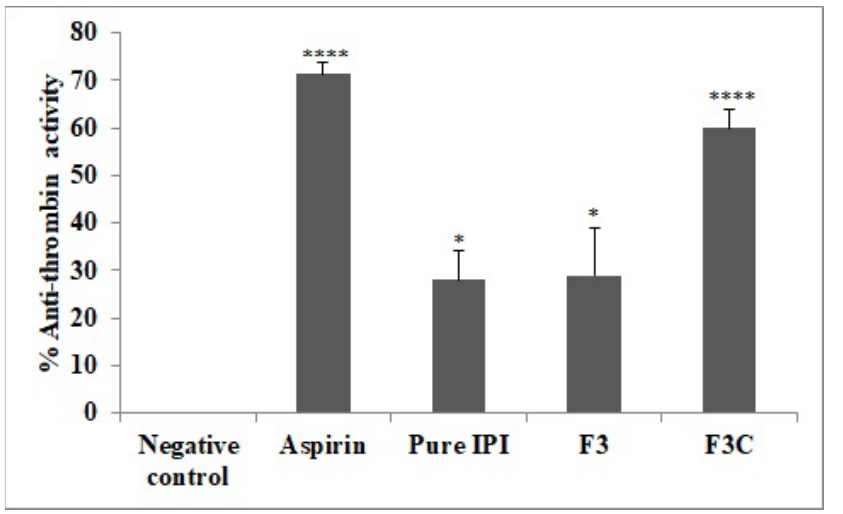
Figure 6. Effect of various treatments on percent anti-thrombin activity. Results are expressed as Mean ± SEM ( n = 6), analysed by one-way ANOVA followed by Dunnett’s test of multiple compar- ison where ns = non-significant, **** p < 0.0001, * p < 0.05 where various treatment groups were compared with negative